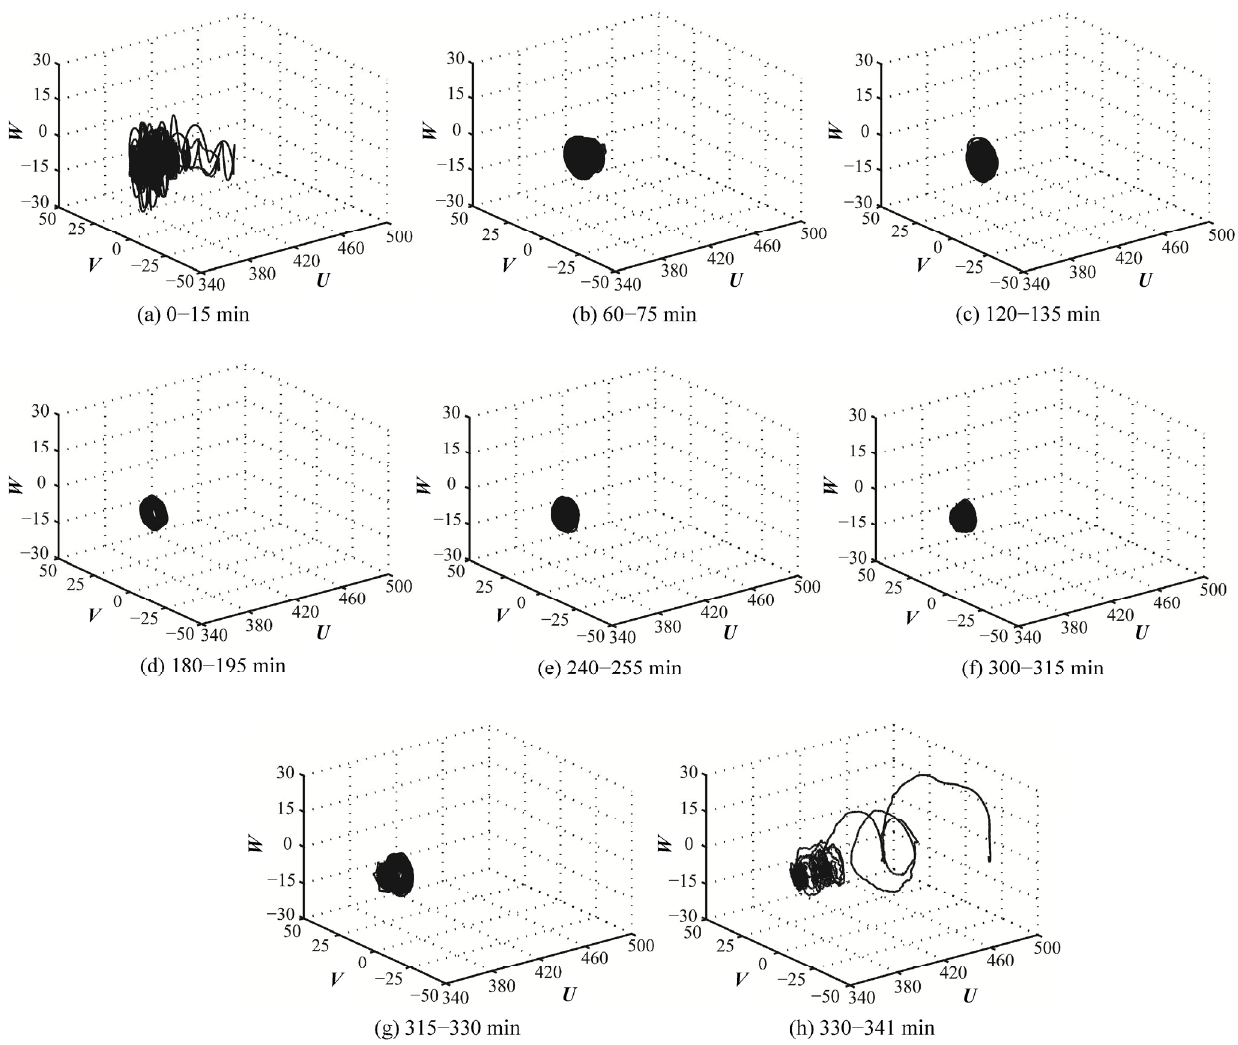
Fig. 8 Evolution of the phase trajectory of friction noise in test